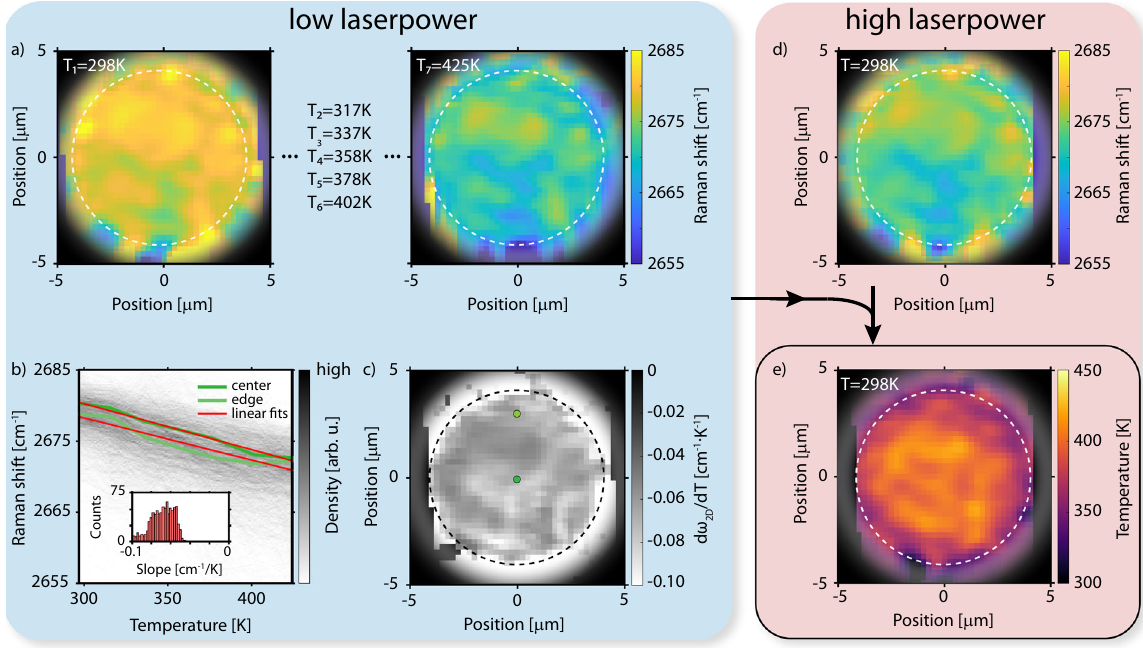
Fig. 2 Experimental determination of temperature map. Spatially resolved mapping of laser-induced temperature rise of graphene. a Raman 2D-peak position obtained with P laser = 0.25 mW at different hot plate temperatures T 1 and T 7 . The dashed circle is a guide to the eye for the support edge. b Density plot of the temperature evolution of the 2D-peak frequency. Two spatial points (center and edge, see dots in c are highlighted to represent the method. The inset shows a histogram of d ω 2D / dT of the complete membrane. c Spatial distribution of change in Raman shift per temperature change d ω 2D / dT obtained from linear fi ts to the data shown in b ). d Raman 2D-peak position obtained with P laser = 4 mW at 297 K. e Temperature distribution obtained by combining the results from c , d